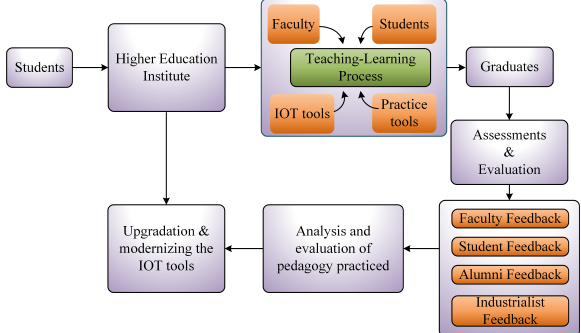
Fig. 1. Closed loop flow diagram of practicing TLP with ICT